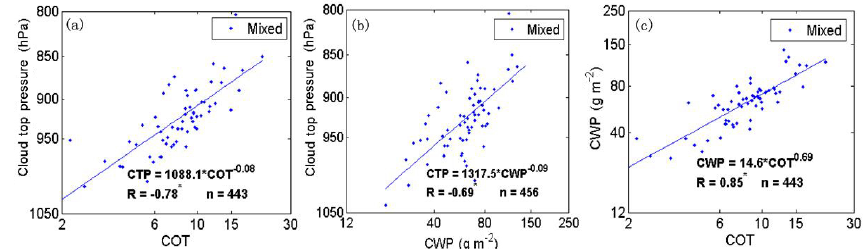
Figure 5. Scatter plots of cloud parameters in well-mixed aerosol cloud layers for all data: (a) CTP versus COT, (b) CTP versus CWP, and (c) CWP versus COT. The lines present the least-square fits, and the resulting relations are presented in each